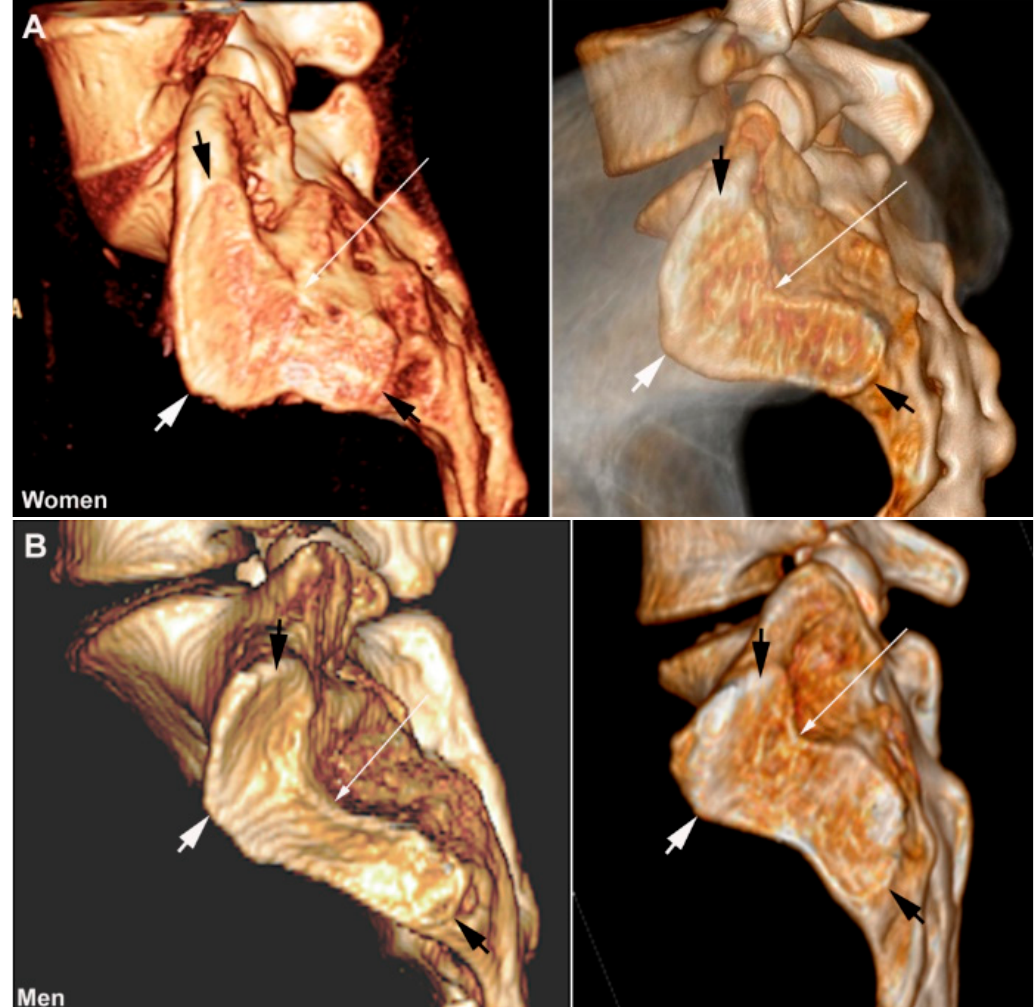
Figure 5. Normal joints, 3D CT reconstructions of the sacral joint facets showing the variable form and sex differences with a more horizontally located joint facet in women ( A ) than in men ( B ). The joint facet in women is usually broadest at the upper and middle portion of the joint whereas the width of the joint facet is less variable in men. The cartilaginous joint facets are marked with black arrow superiorly and inferiorly and with white arrows on the most anterior portion and thin white arrows at the deepest posterior point at the transition between the cartilaginous and ligamentous joint portion.